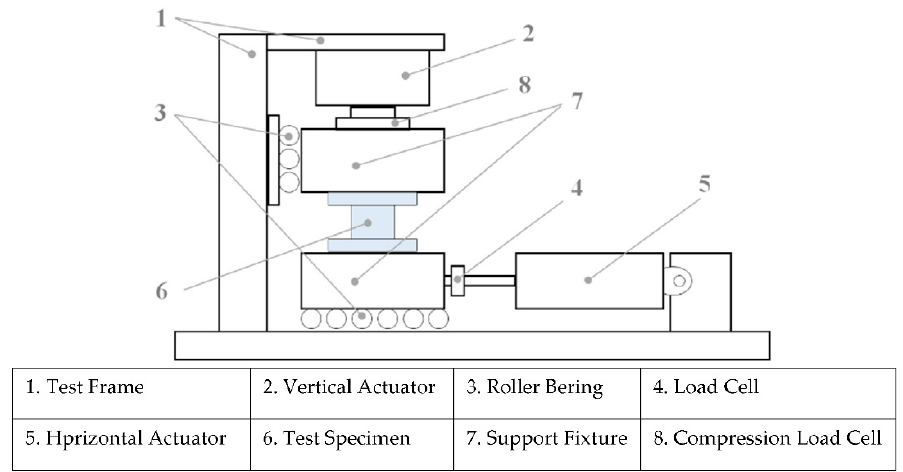
Figure 3. Schematic diagram of static test.